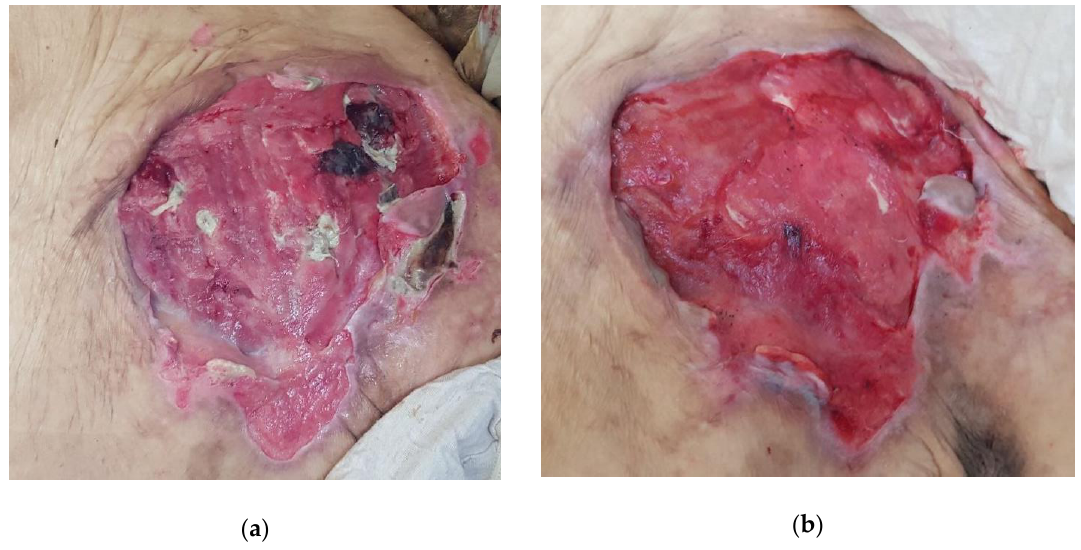
Figure 4. Clinical Case 3 of Pseudomonas infected pressure ulcer treated with L-Mesitran Soft. ( a )